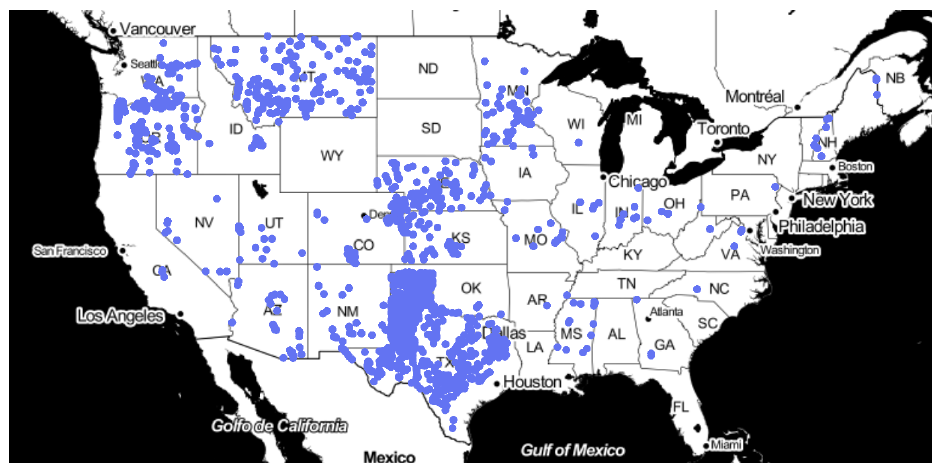
Figure 6. Distribution of ground-truth GWLA values for the national model.